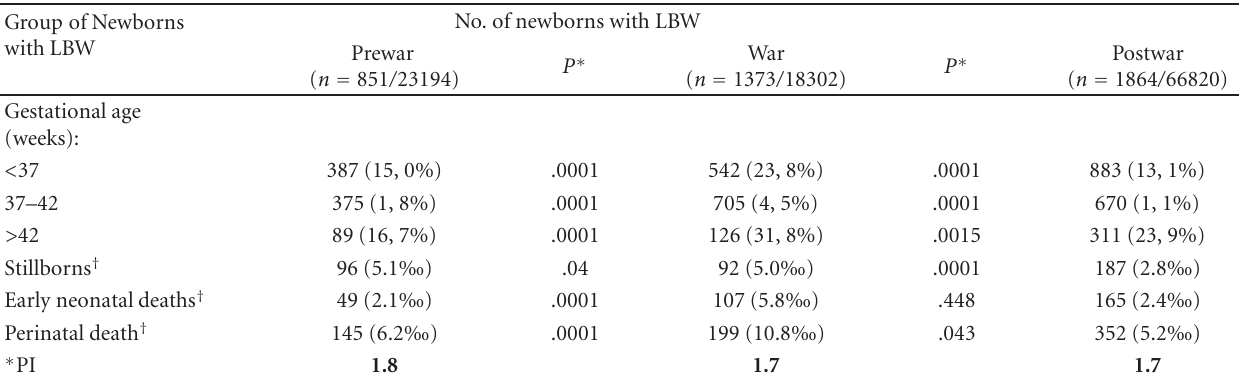
Table 1: Number of Low birth weight (LBW) infants according to gestational age, stillbirths, early neonatal mortality, and total perinatal mortality Low birth weight (LBW) infants at University Clinical Center Department for Gynecology and Obstetrics in the prewar